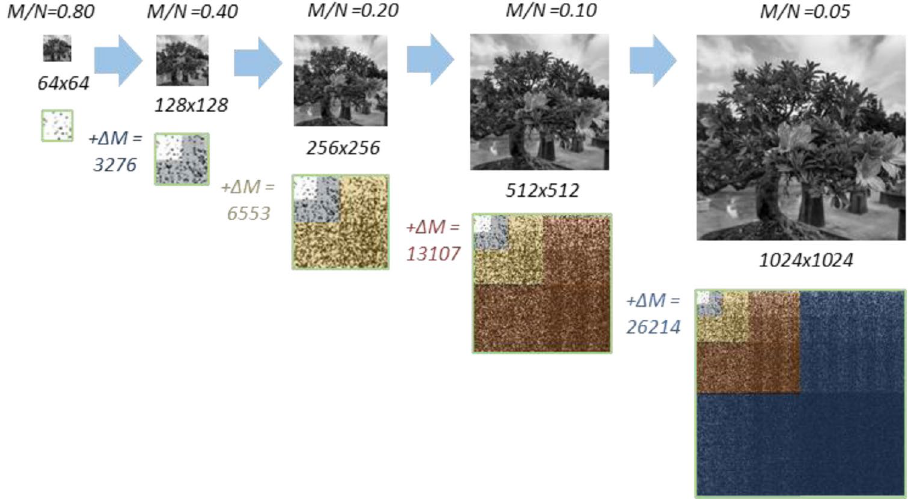
Figure 6. The progressive sampling process. The image and its 2D Paley Ordered Hadamard samples below it, are illustrated in sequential order. The first stage starts at a low-resolution image. To increase the resolution, an appropriate additional set of ΔM compressive samples, (highlighted in color) is added to the 2D Hadamard transform of the image. The Hadamard samples ordered in 2D are illustrated below the multiscale